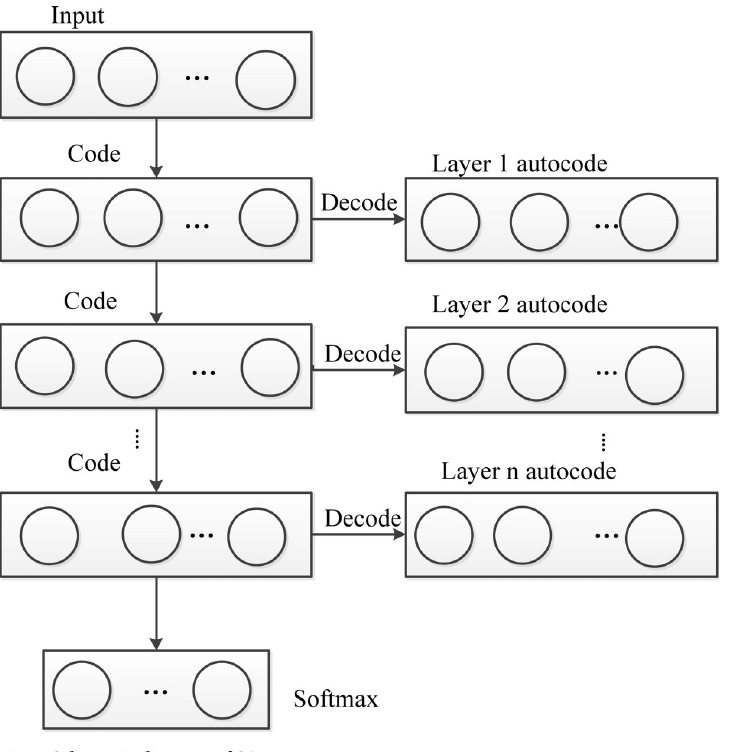
Fig 3. Schematic diagram of SAE